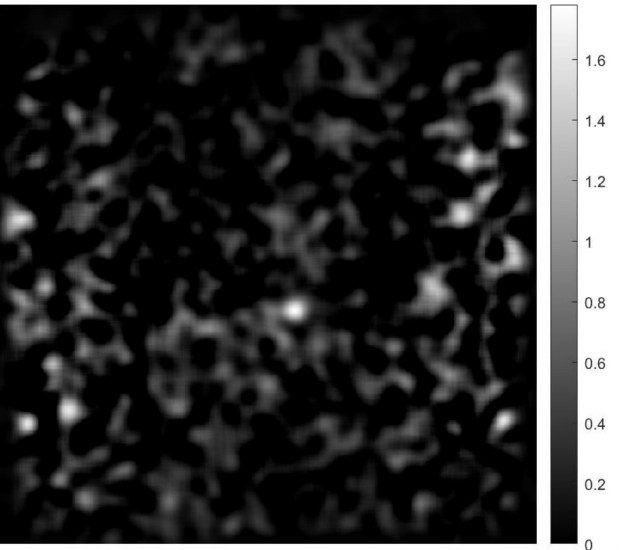
Figure 22. Results (720 × 720) of a deep lying tumor with 5 mg/mL of Au.